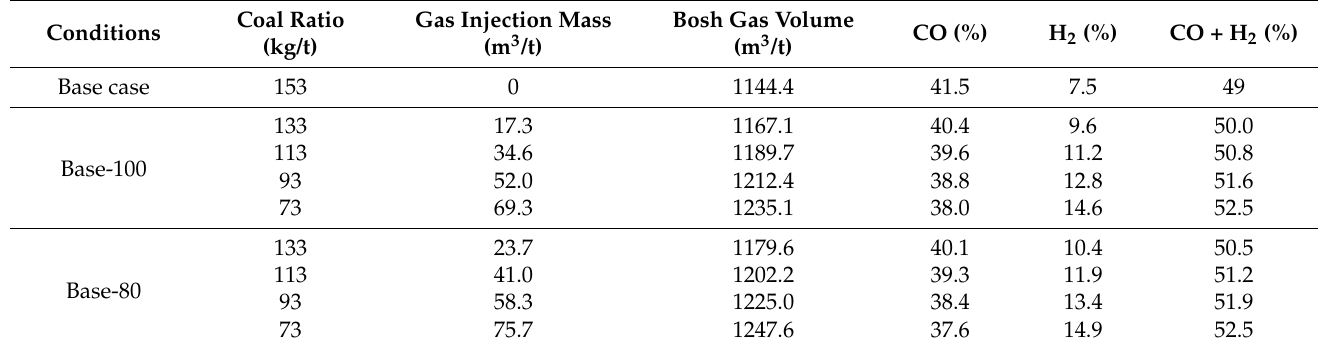
Table 5. Volume and composition of bosh gas under different acceptable quantities of NG.